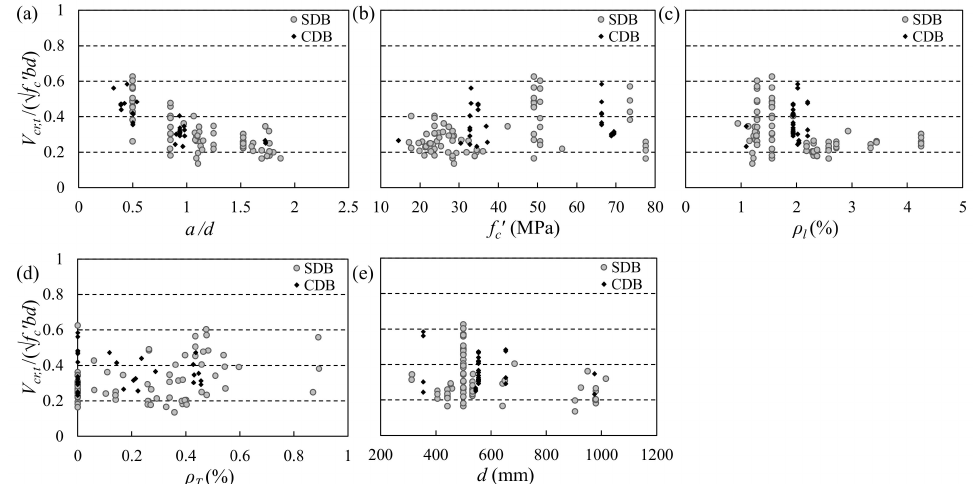
√ f c (cid:48) bd ) and